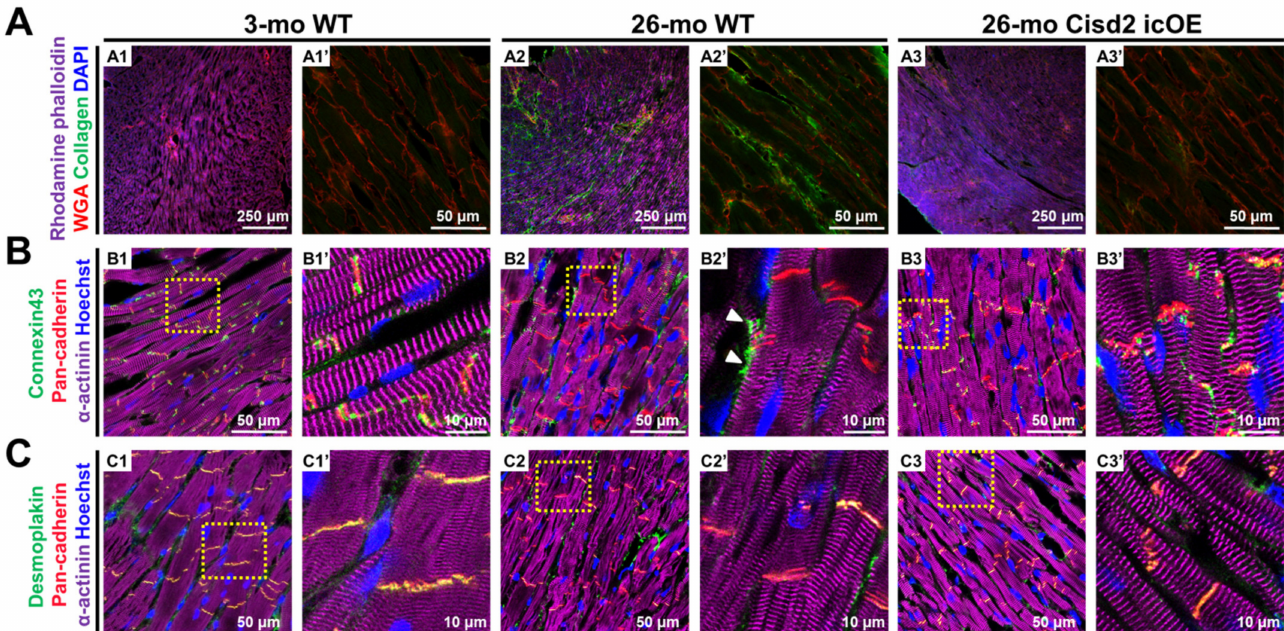
Figure 3. Cardiac-specific overexpression of Cisd2 at a late-life stage rescues the aging hearts of mice from age-related cardiac fibrosis and intercalated disc (ICD) defects. ( A ) Age-related cardiac fibrosis can be seen to be ameliorated by enhancing the expression level of Cisd2 in the aging heart. Representative immunofluorescence images of heart sections from the three groups of mice (3-mo WT, 26-mo WT, and 26-mo Cisd2 icOE) stained with antibodies against collagen I (green) and wheat germ agglutinin (red) to identify the cell membrane, with rhodamine phalloidin—to identify actin (purple), and with DAPI—to identify the cardiomyocytic nucleus. Age-related cardiac fibrosis is obvious in the 26-mo WT mice ( A2 ). However, overexpression of cardiac Cisd2 appears to reduce cardiac fibrosis ( A3 ). ( B , C ) Overexpression of Cisd2 reverses the age-related defects affecting the ICD in the aging heart. Representative immunofluorescence images of heart sections from the three groups of mice (3-mo WT, 26-mo WT, and 26-mo Cisd2 icOE) stained with antibodies against Cx43 (green) was used to localize gap junctions, against pan-cadherin (red)—to localize the ICDs, and against α -actinin (purple)—to stain muscle fibers. The sections were also stained with Hoechst (blue) to identify the nuclei. Cx43 is well-co-localized with pan-cadherin in hearts of the 3-mo WT mice ( B1 ). However, lateralization and loss of co-localization of Cx43 with pan-cadherin were found in hearts of the 26-mo WT mice ( B2 ). White arrows indicate lateralization of gap junctions. Maldistribution of desmosomes was found in the hearts of 26-mo WT mice ( C ). Co-localization of desmoplakin (green) with pan-cadherin ( C1 ) was found within desmosomes of the 3-mo WT mice, and this was lost in hearts of the 26-mo WT mice ( C2 ). Remarkably, defects in the ICD were reversed by cardiac-specific overexpression of Cisd2 ( B3 , C3